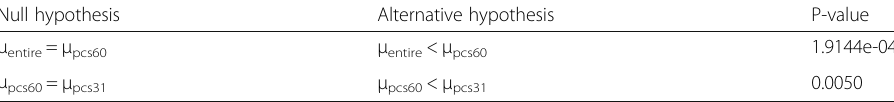
Table 5 Comparison of classification results from DNN classifiers for three data sets Null